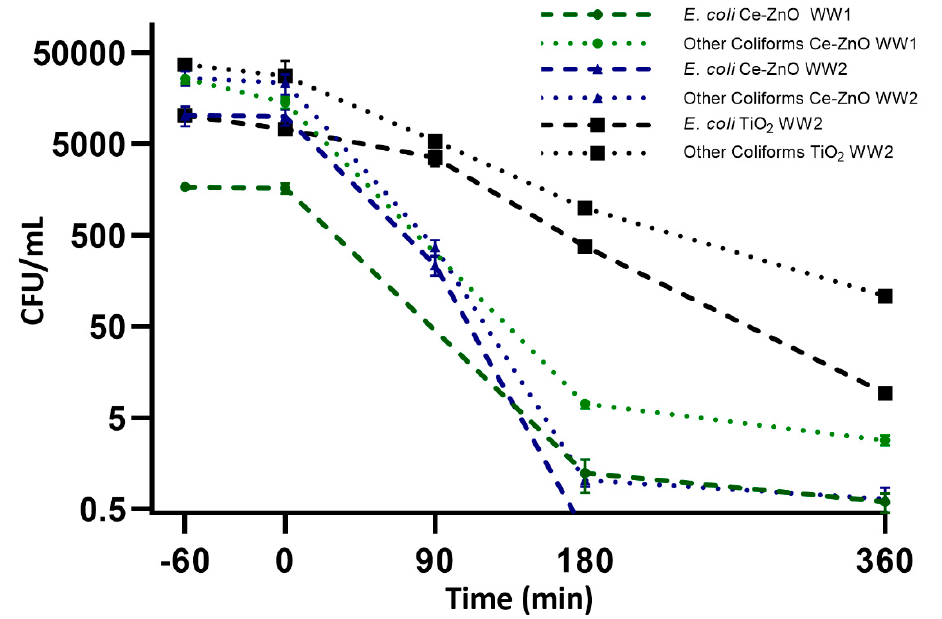
Figure 7. Inactivation of E. coli and other coliforms Conditions: 750 mL of WW and 380 cm 2 photocatalyst coated discs with 36 W UVA.